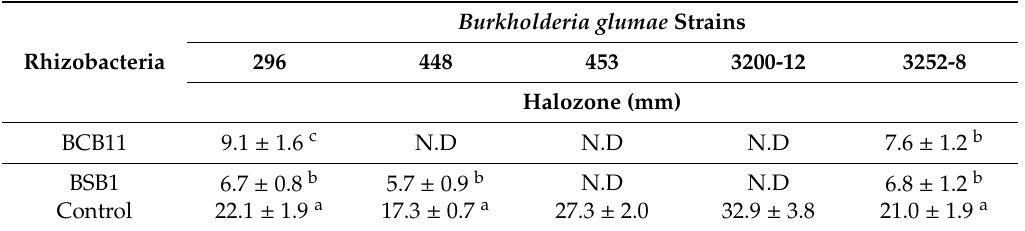
Table 1. The inhibition halozones produced by antagonistic rhizobacteria toward Burkholderia glumae ( B. glumae